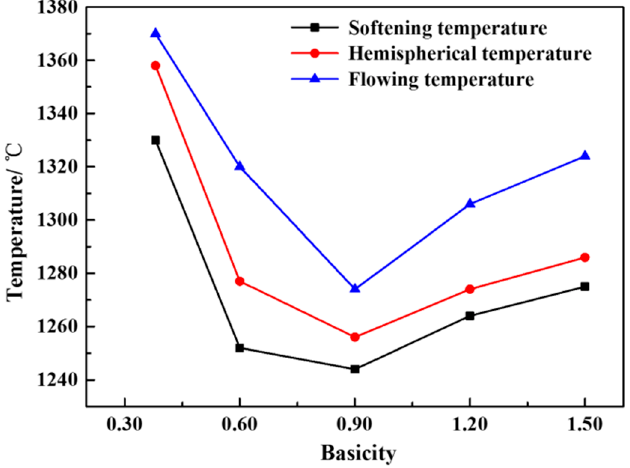
Figure 5. Effect of basicity on characteristic temperature of a CaO-SiO 2 -FeO-MgO system. Figure 5. E ff ect of basicity on characteristic temperature of a CaO-SiO